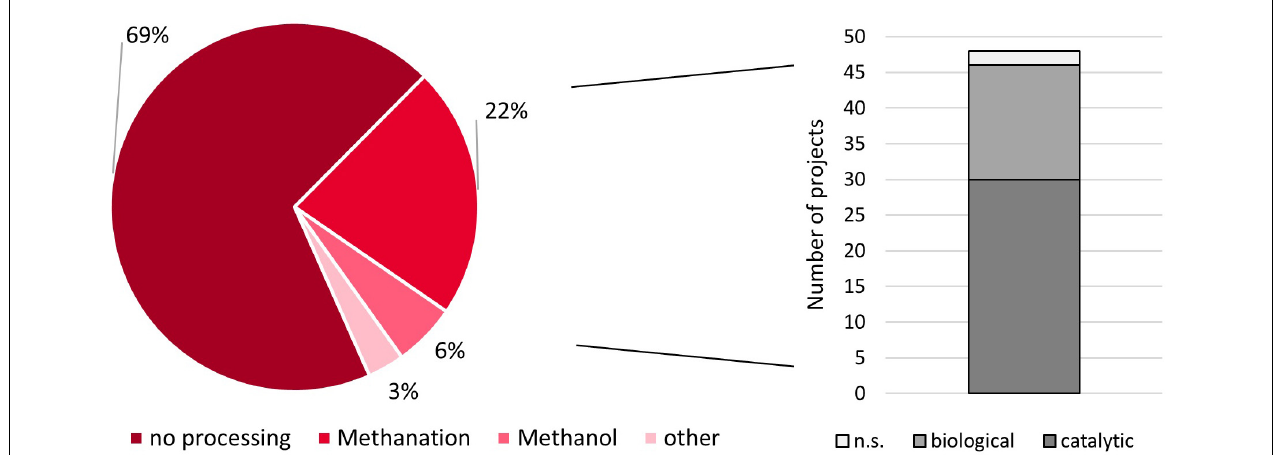
FIGURE 8 | Process steps of Power-to-X projects in Europe with a focus on methanation technologies, n.s., not